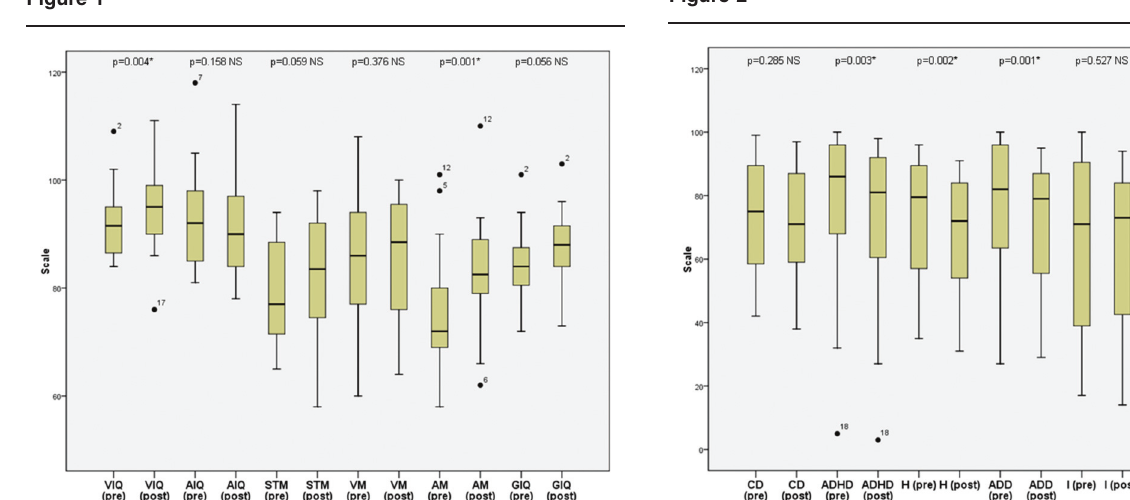
Box and whisker graph of Stanford Binet Scale scores in the studied groupbefore(pre)andafter(post)therapy.Thethicklinein themiddle of the box represents the median, the box represents the interquartile range (from 25th to 75th percentiles), and the whiskers represent the minimum and maximum after excluding outliers (black-filled circles) (numbers indicate the serial number of the case in the master table). AIQ, abstract visual intelligence quotient; AM, auditory memory; GIQ, general intelligence quotient; STM, short term memory; VIQ, verbal intelligence quotient; VM, visual memory.